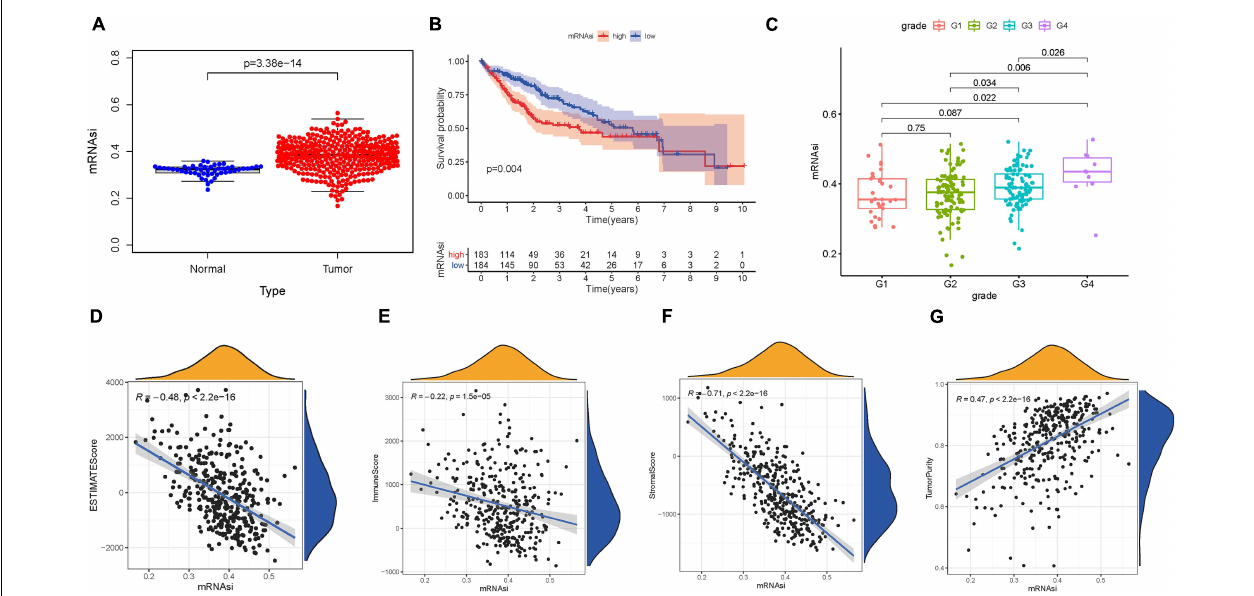
FIGURE 1 | Clinical characteristics and molecular features correlated with the mRNA expression-based stemness index (mRNAsi) in hepatocellular carcinoma (HCC). (A) Differences in mRNAsi between normal (50 samples) and tumor (374 samples) tissues. (B) Kaplan–Meier curves show that the low mRNAsi subgroup had greater mortality than does the high mRNAsi subgroup. (C) Boxplots of mRNAsi value in individual samples stratified by tumor grade. Correlation between mRNAsi score and Estimation of Stromal and Immune Cells in Malignant Tumors Using Expression Data (ESTIMATE) score (D) , stromal score (E) , immune score (F) , and tumor purity (G)